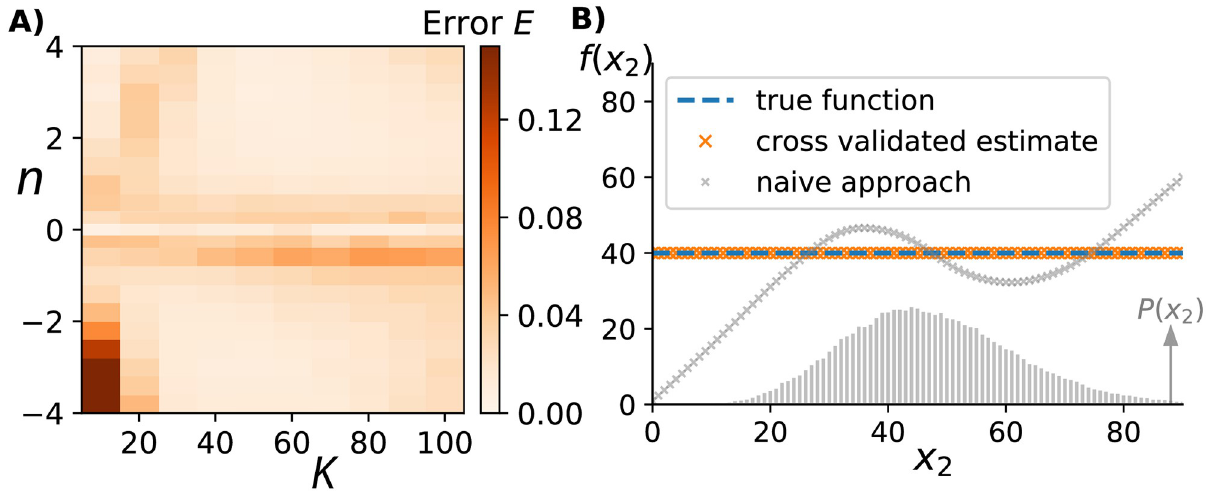
Fig 7. Cross-validation improves inference in regions with constant to near constant rates. A) Analogous to Fig 4 we change the shape of the production rate f ð x Þ ¼ l x n = ð x n þ K n Þ by varying K and n . Shown here is the error of the inferred f ( x 2 ) when applying our method with an additional 2 2 2 cross-validation step as detailed in the Materials & Methods. The quality of the inference is significantly improved in the regime in which the production rate is essentially independent of the upstream variable around n � 0. B) Directly comparing the cross-validated and freely inferred f ( x 2 ) when applied to a system in which the true production rate was constant. The cross-validated answer picks out the constant production rate, whereas the naive approach gives a varying estimate due to overfitting of Eq